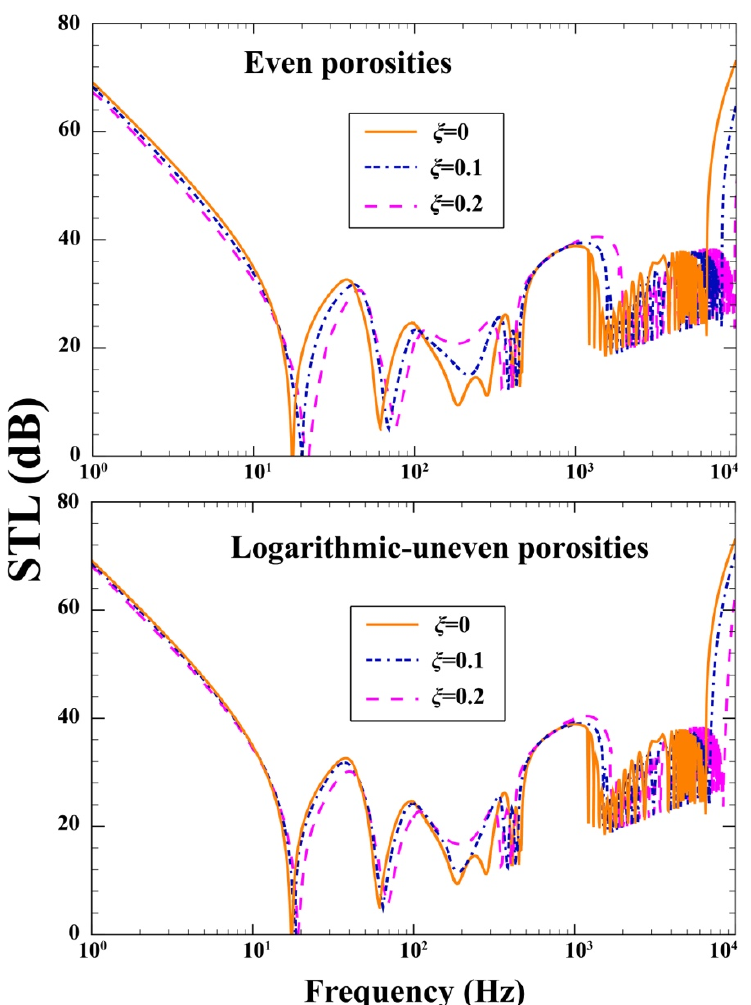
Figure 9. Effect of different porosity distributions and porosity coefficient on the changes of STL.